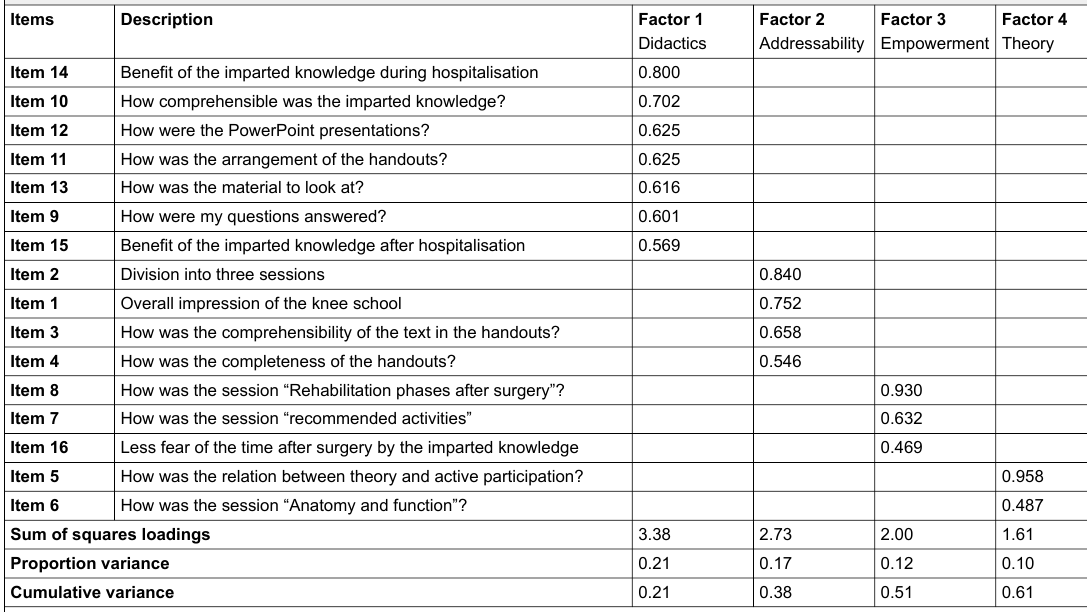
Table 4: Factor analysis with loadings of the 16 items of the KOPEQ on the 4 extracted